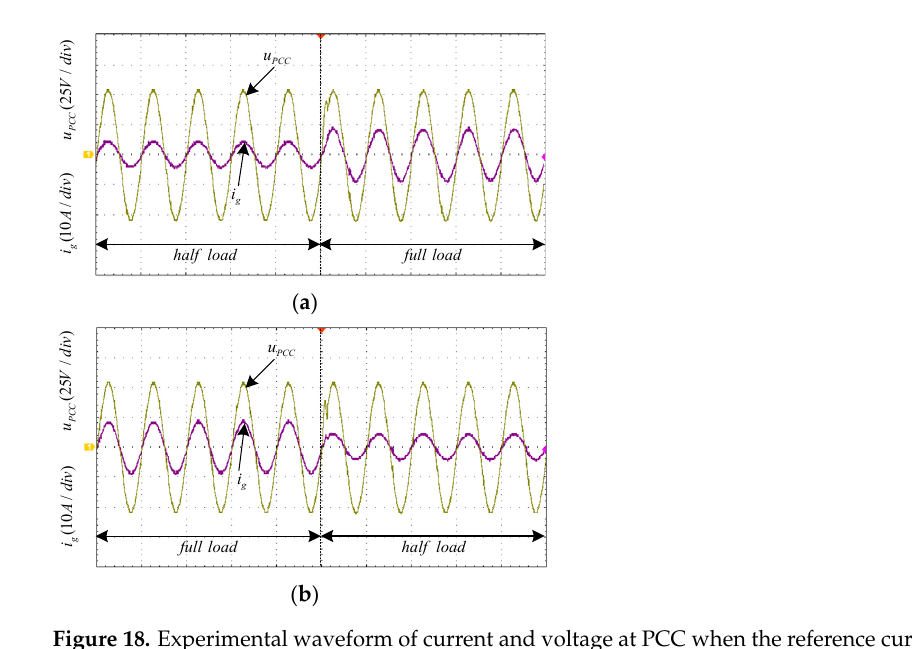
( b ) Figure 17. Experimental waveform of current and voltage at PCC for different SCR after impedance reshaping: ( a ) L g = 0 (SCR > 10); ( b ) L g = 10 mH (SCR = 3). Subsequently, to verify the dynamic performance of the proposed control method, the experimental waveform of the current and voltage at PCC when the reference current changes abruptly is shown in Figure 18. It can be observed that after impedance reshap-